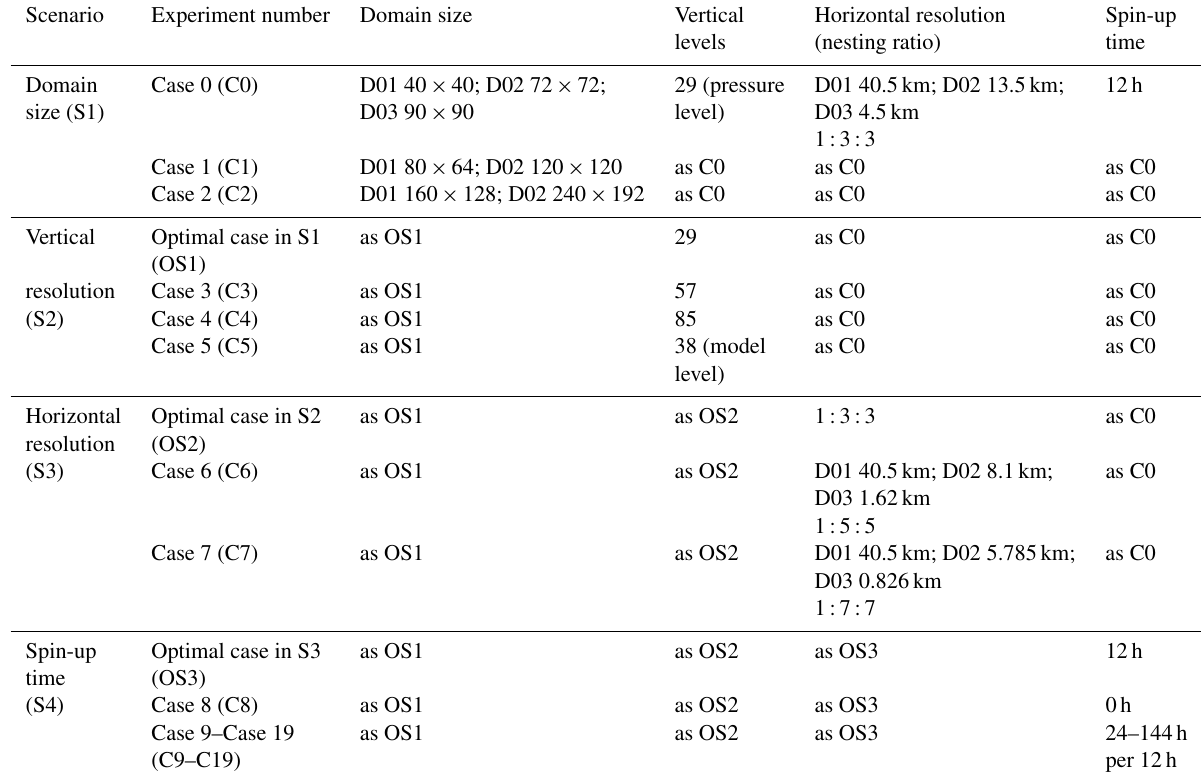
Table 1. Categories of experiments with different domain sizes, vertical resolutions, horizontal resolutions and spin-up times.